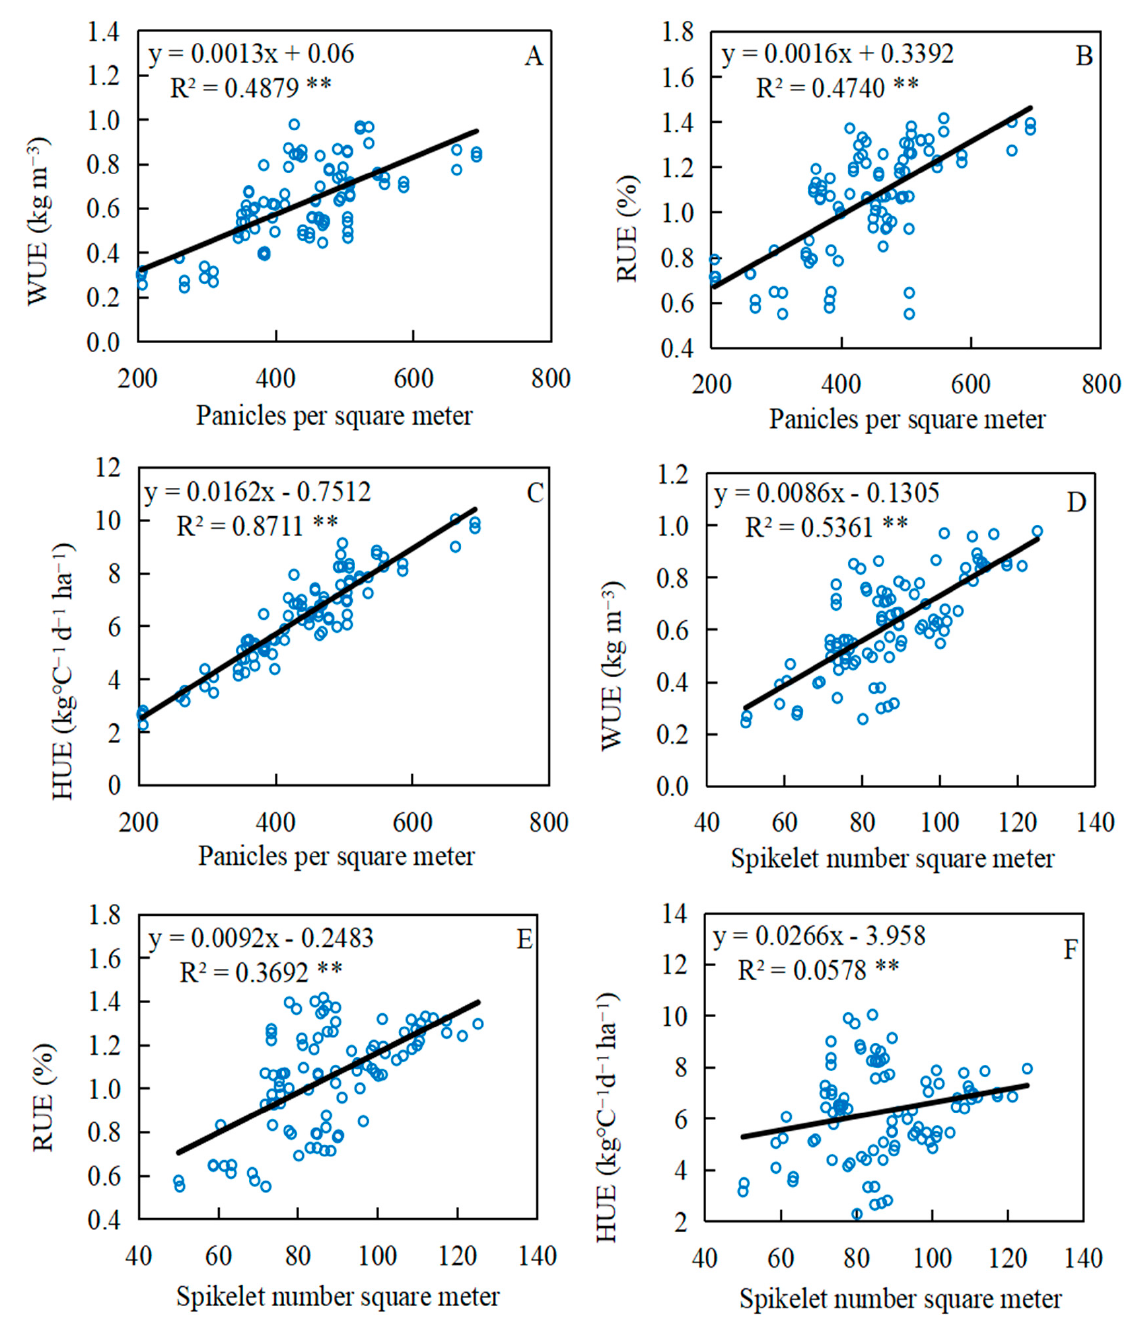
Figure 7. Correlations between panicles per square meter and water-use efficiency (WUE) ( A ), radiation-use efficiency (RUE) ( B ), and heat-use efficiency (HUE) ( C ); and spikelets per panicle and WUE ( D ), RUE ( E ), and HUE ( F ) throughout the growth period. **, *: Significant at 1% and 5% probability levels, respectively.